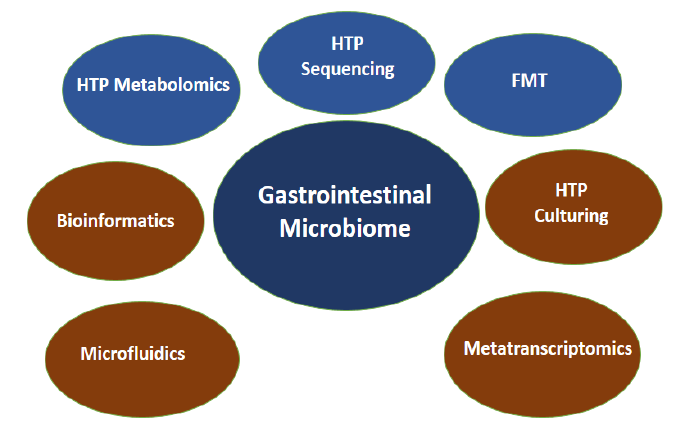
Figure 1. Various technologies used in the study of gastrointestinal microbiome. HTTP: high-throughput, FMT: fecal microbiota